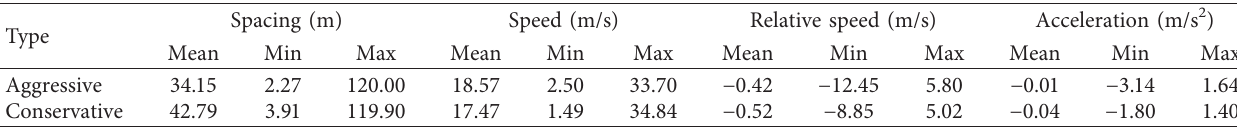
Table 1: Descriptive statistics for different driving styles.